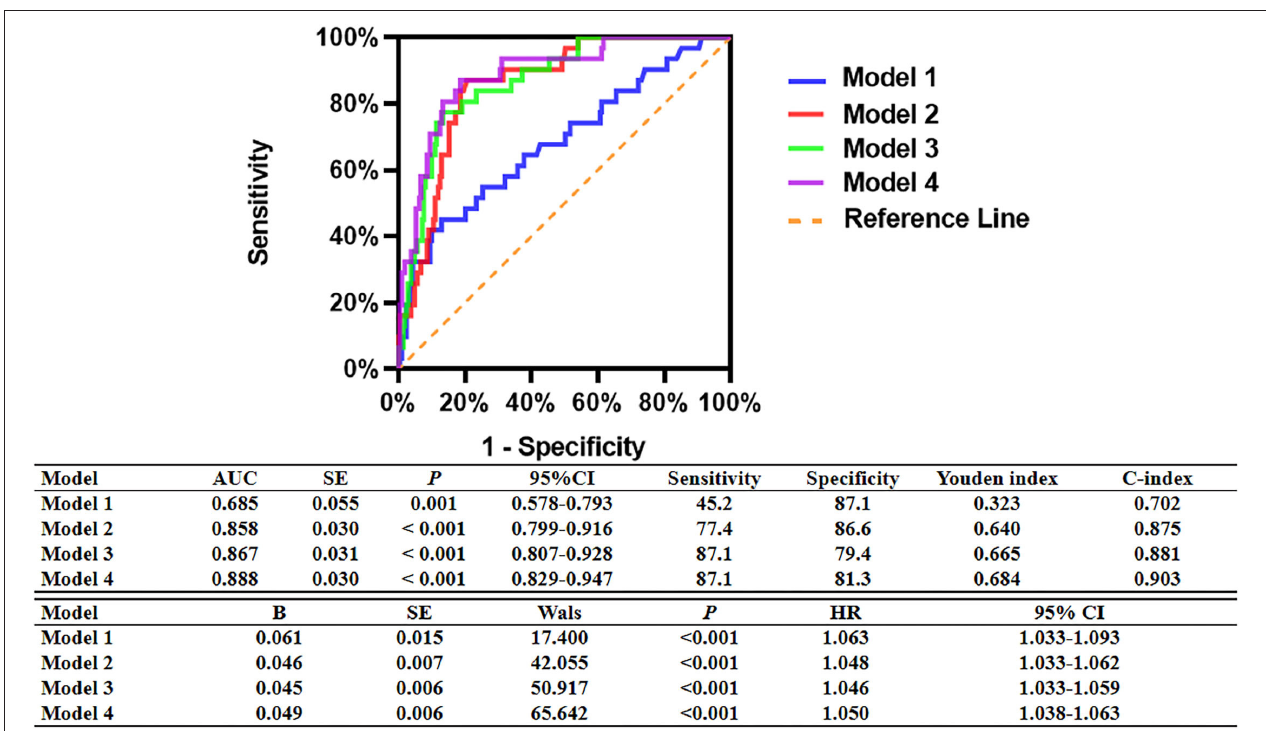
FIGURE 7 | Comparison of the predictive capacity and accuracy of predictive models for MACCEs. Model 1: Age + Sex + Hypertension + Diabetes mellitus + Current smoking + Family history of CAD + History of myocardial infarction. Model 2: Model 1 + Post-PCI QFR of the target vessel ≤ 0.88. Model 3: Model 2 +